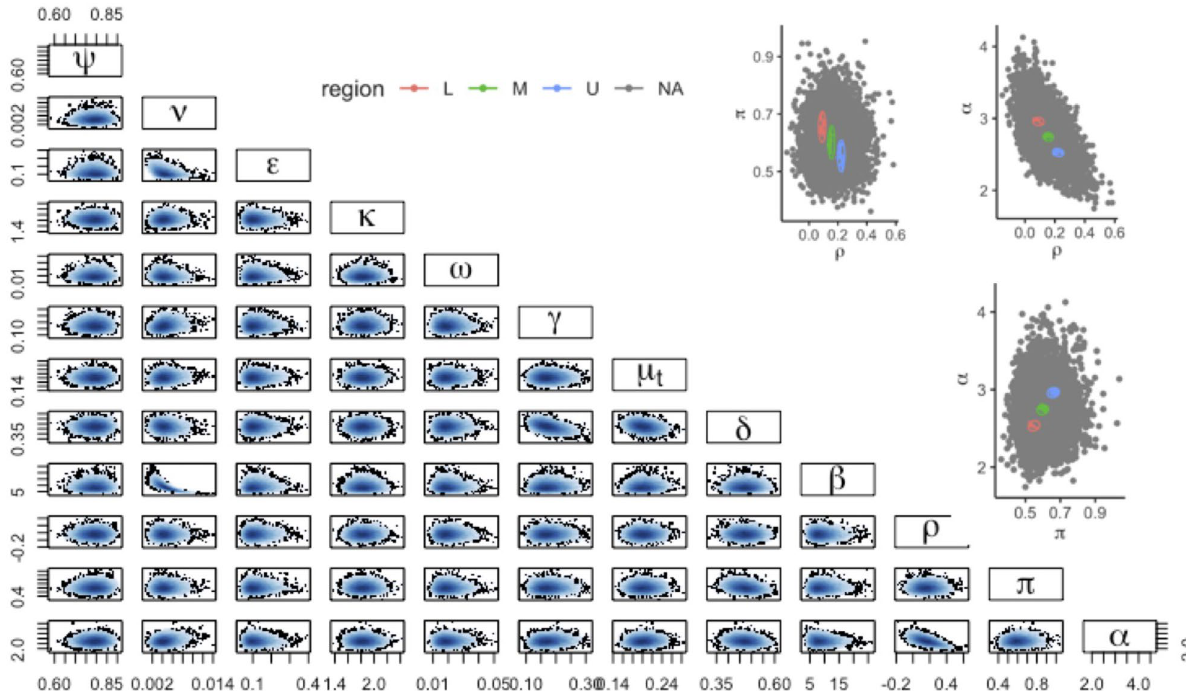
Figure 4. Correlation between model parameters. The lower left corner plot shows the smoothed posterior samples ( ψ —partial protection, ν —reactivation, ǫ —fast progression, κ —stabilization, ω —relapse, γ —self-cure, µ t —TB mortality, p —detection, β —effective contact, ρ —assortativity, π —differential detection, α —differential progression). The upper right plots show the ‘L’, ‘M’, and ‘U’ ellipses used for the sensitivity analysis in Table 3.